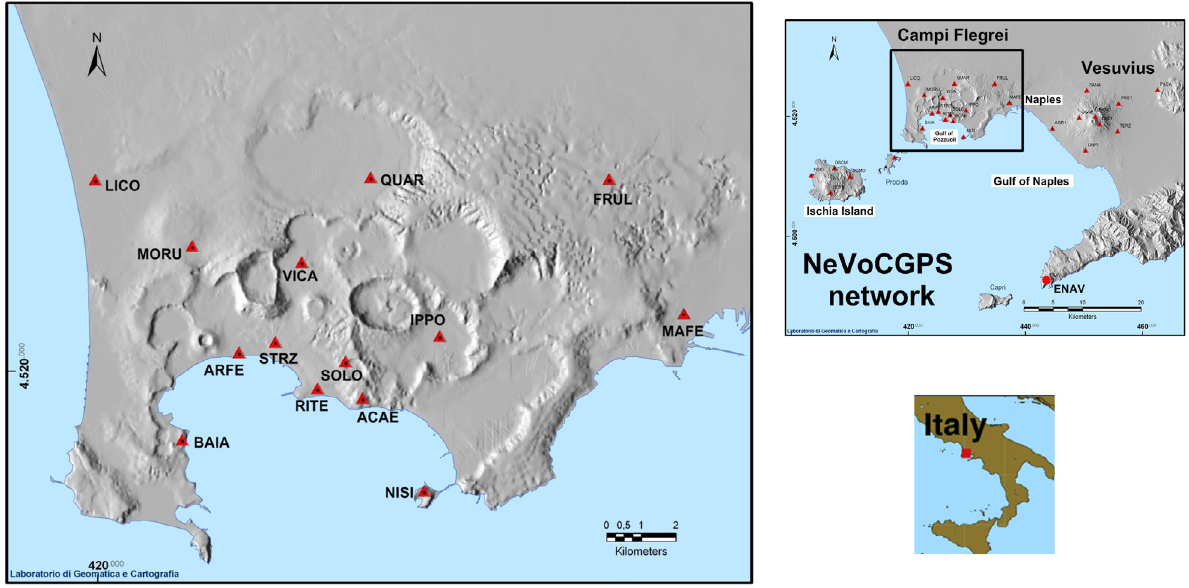
Figure 1. Map of NeVoCGPS network. Red triangles indicate GPS permanent stations. The box on the left shows CF area and the stations used in this paper.